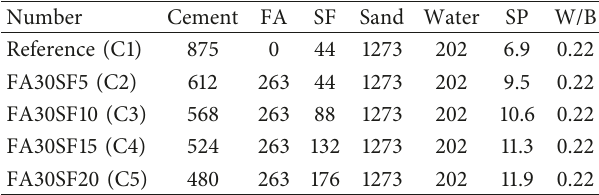
Table 2: Mixture proportions of designed concrete (kg/m 3